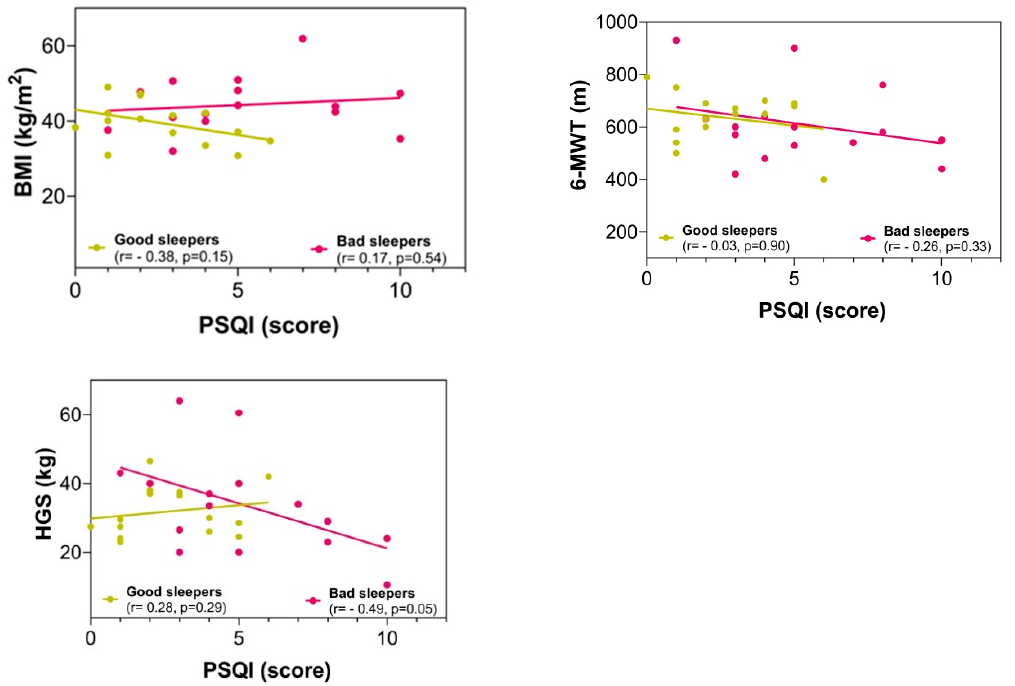
Figure 2. Correlation between the sleep quality score with anthropometric and fitness variables in post-intervention. BMI = body mass index; 6-MWT = six-minute walking test; HGS = handgrip strength; PSQI = Pittsburgh Sleep Quality Index.